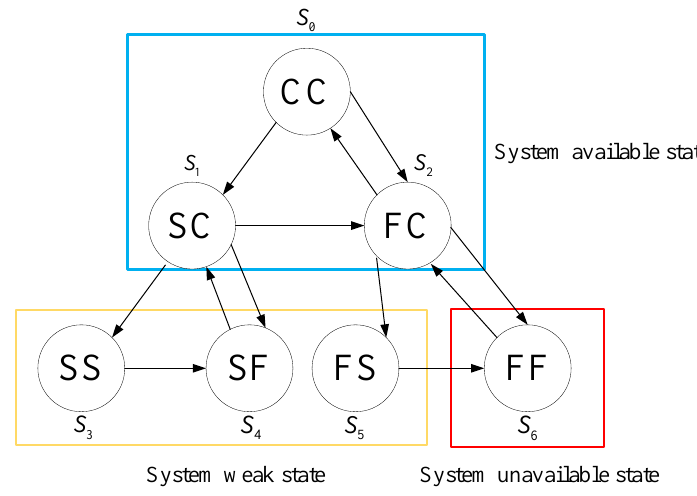
Figure 3. The state transfer among the dual cluster head